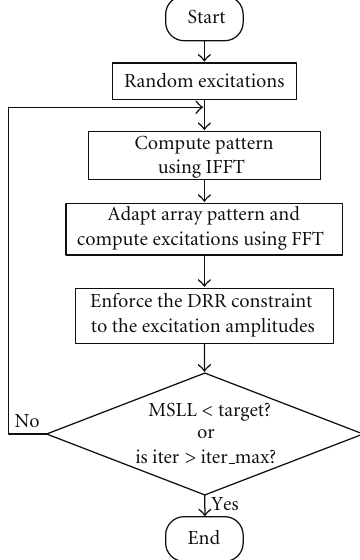
Figure 4: Flowchart of the iterative Fourier technique for fractal- based planar-array pattern